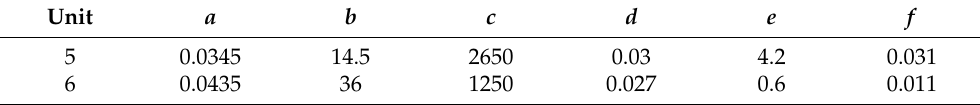
Table 6. Cost coefficients for CHP units.